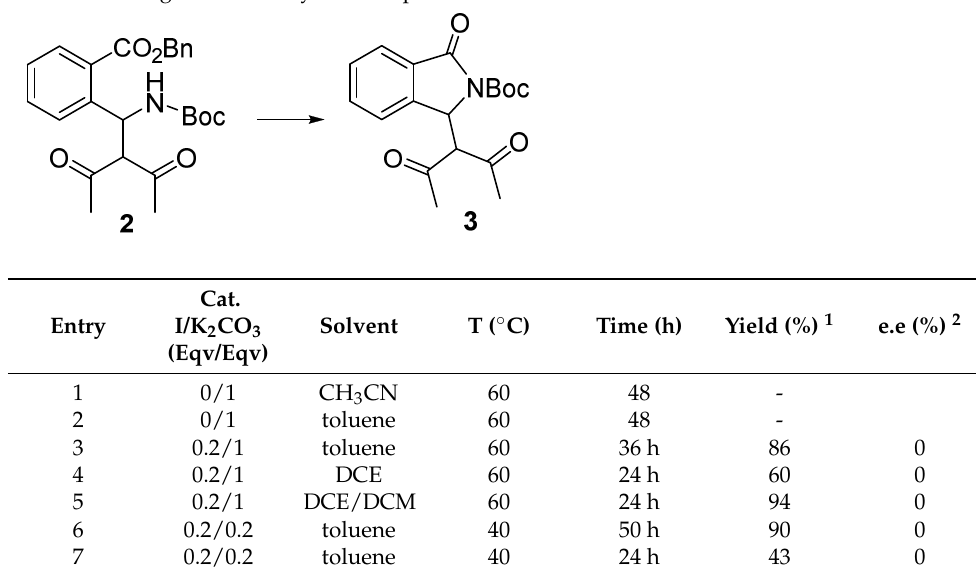
experiment was repeated and stopped at about 50% conversion (Entry 7). Again, the cyclic product was racemic, while the unreacted acyclic intermediate maintained 88% ee. Table 3. Investigation of the cyclization process. Table 3. Investigation of the cyclization process.